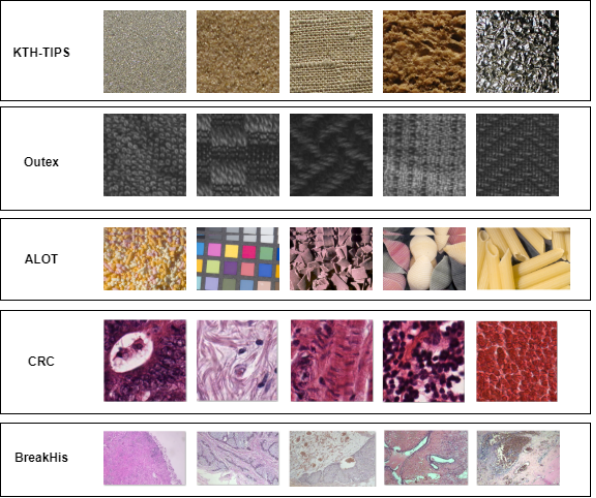
Figure 3. Sample images from different